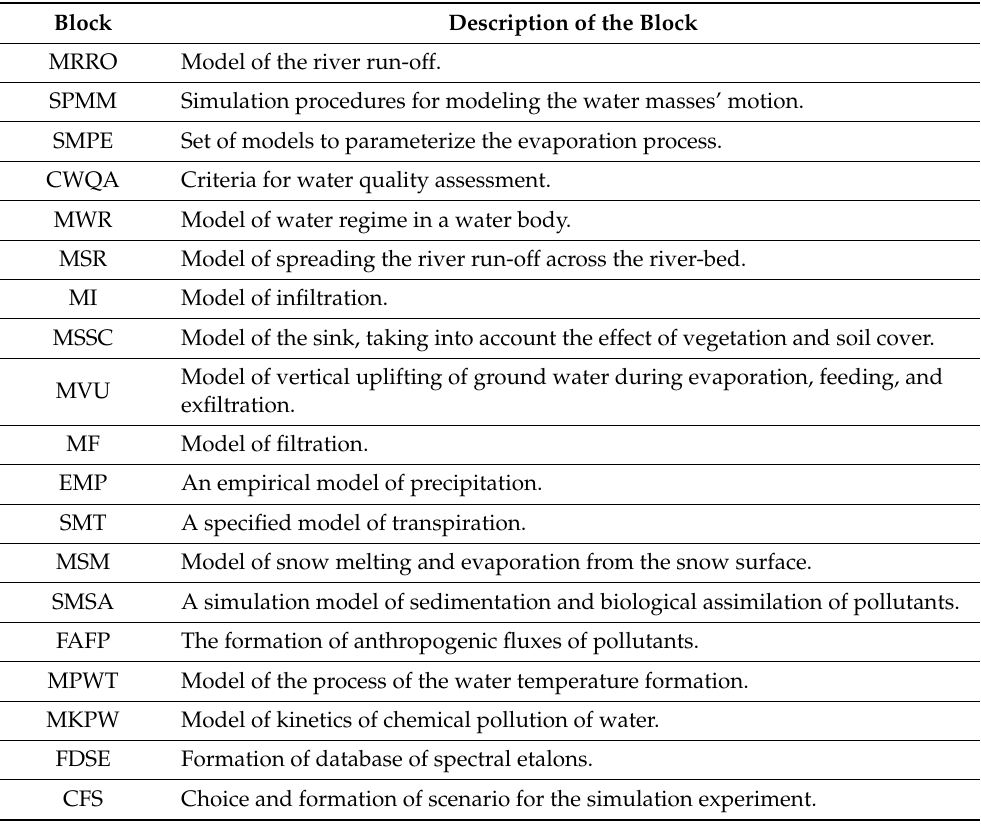
Figure 5. Structure of the AYRSSM. The description of the main blocks is given in Table 2. Table 2. List of main blocks of AYRSSM.